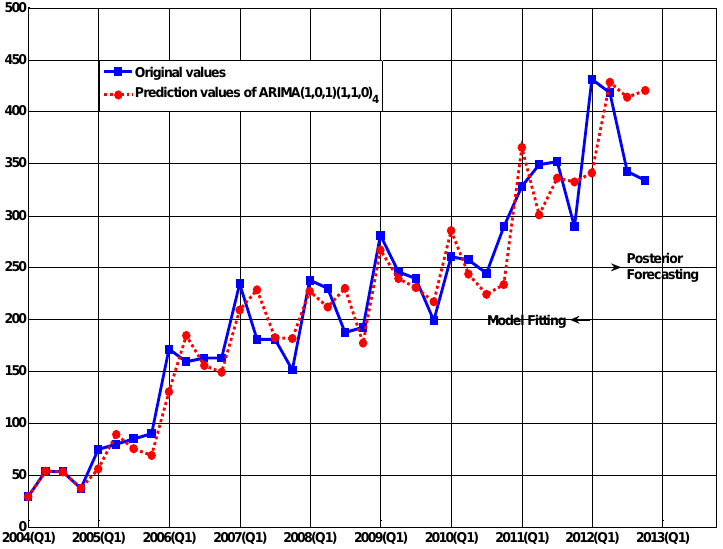
Figure 4. The comparison between the real values and the simulation values of the ARIMA(1,0,1)(1,1,0) 4 model.